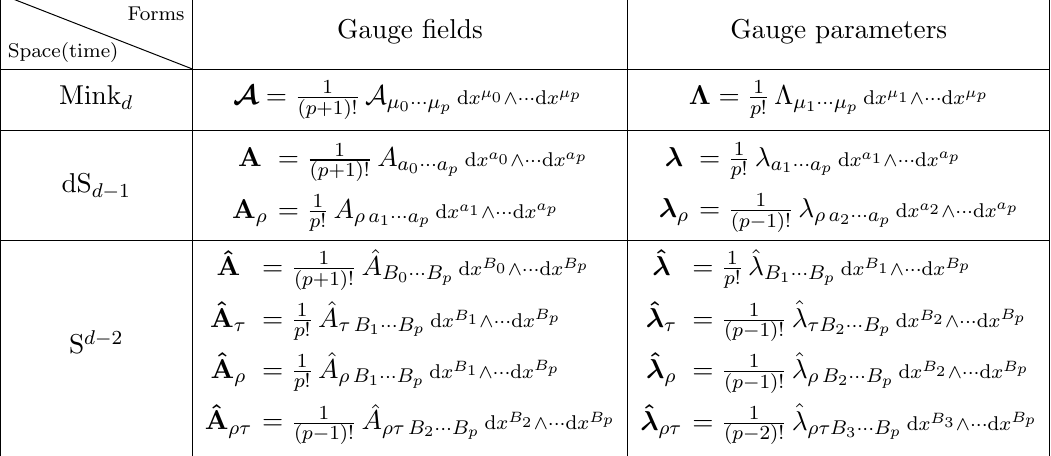
Table 1 . Summary of notations for forms. Bold letters A ( (cid:3) ), A ( (cid:21) ) and ^ A ( ^ (cid:21) ) stand for abstract gauge (cid:12)elds (parameters) as di(cid:11)erential forms on Mink d , dS d (cid:0) 1 and S d (cid:0) 2 respectively. with